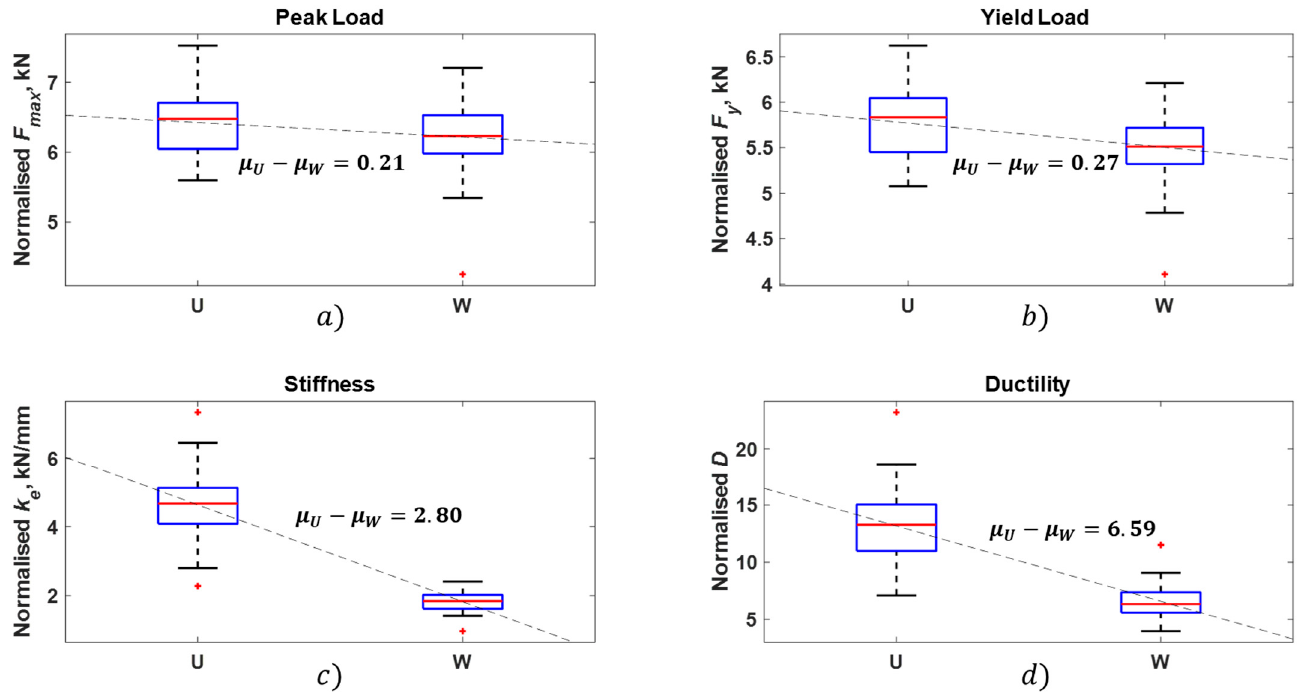
Figure 9. Boxplot comparisons of unweathered (U) and weathered (W) STC specimens by normalised ( a ) peak load, ( b ) yield load, ( c ) stiffness, and ( d ) ductility.